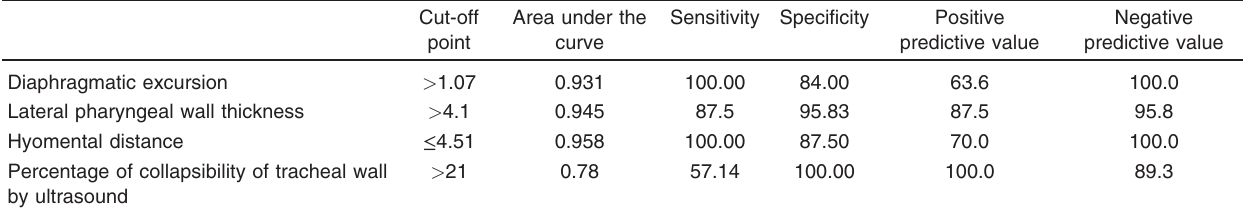
Table 7 Predictive power of different sonographic parameters among the intubated group of patients